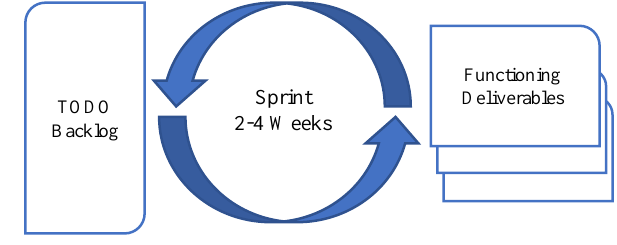
Figure 1 . Scrum events and